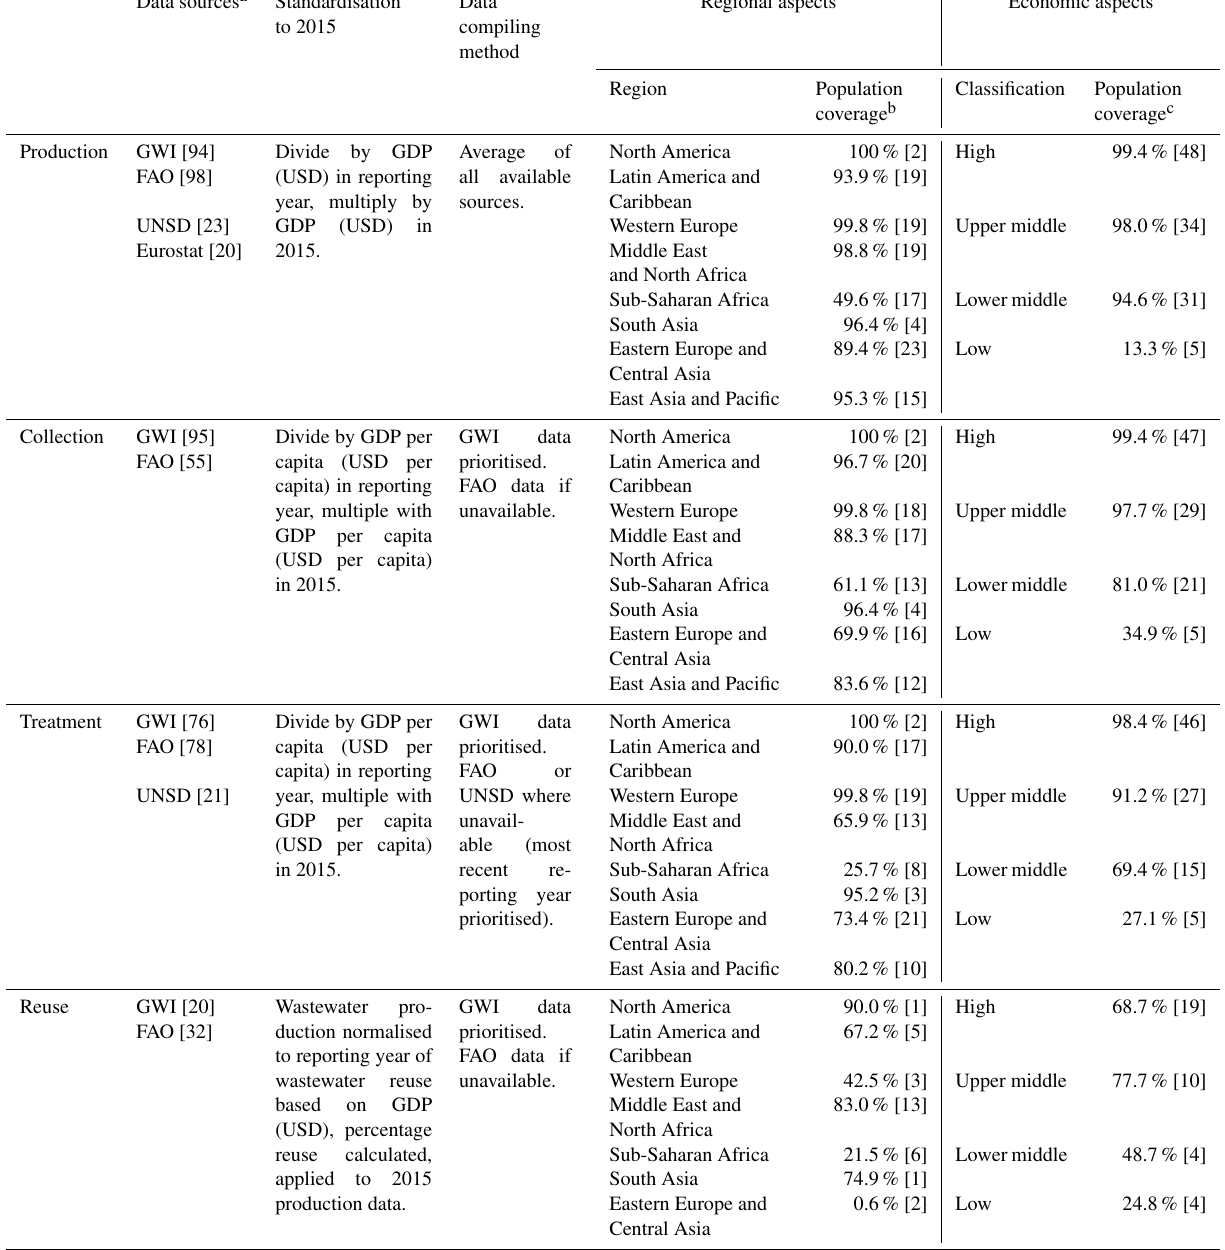
a Abbreviations for the data sources are as follows: Global Water Intelligence (GWI), Food and Agriculture Organization of the United Nations (FAO), United Nations Statistics Department (UNSD), European Union statistics office (Eurostat). b Data availability per region expressed as a percentage of the total population. Geographic region followed by the total number of countries per region in square brackets: East Asia and Pacific [38], eastern Europe and Central Asia [30], Latin America and Caribbean [41], Middle East and North Africa [21], North America [3], South Asia [8], sub-Saharan Africa [48], and western Europe [26]. c Data availability per economic classification expressed as a percentage of the total population. Total number of countries per economic classification are: high [76], upper-middle [56], lower-middle [52] and low [31] income.